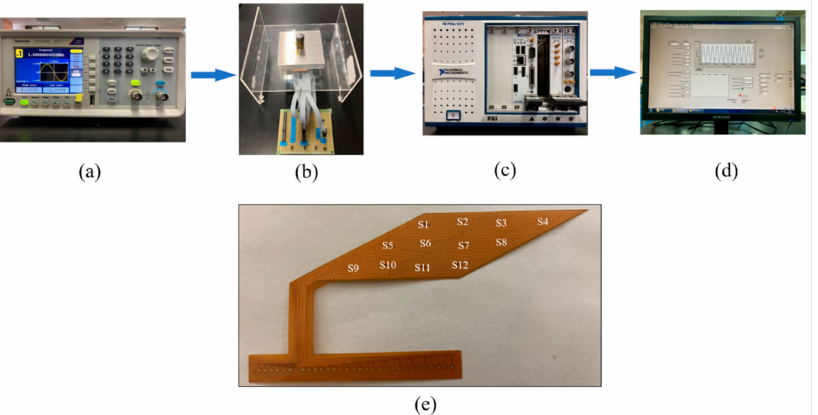
Figure 15. Experimental setup and sensor film. ( a ) Signal generator; ( b ) intelligent bolt; ( c ) signal receiver; ( d ) signal displayer; ( e ) eddy current sensing